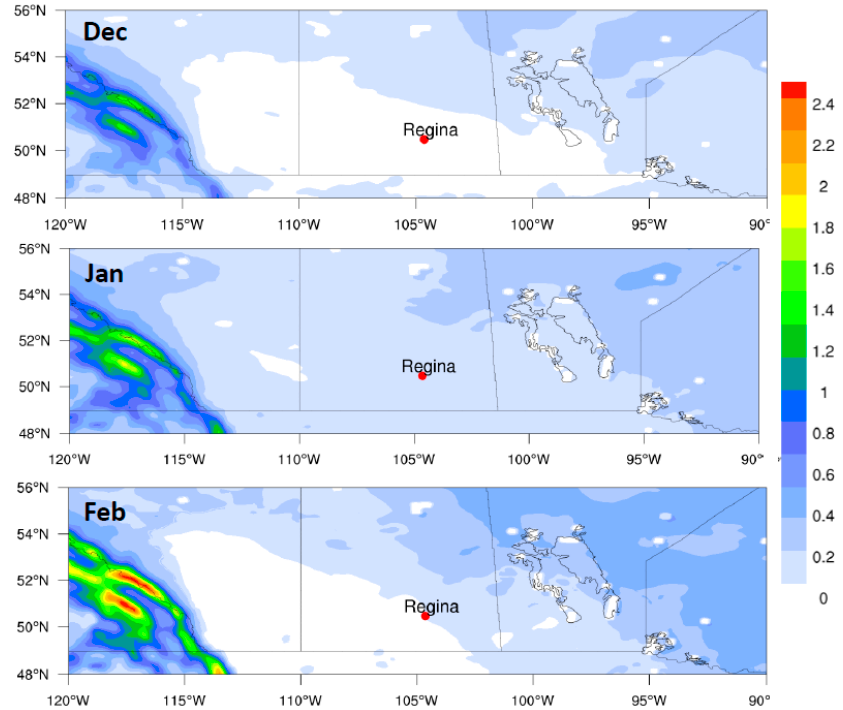
Figure 7. WRF simulated snow depth (m) in the winter of 2015–2016 in ELX experiment. Water 2020 , 12 , x FOR PEER REVIEW